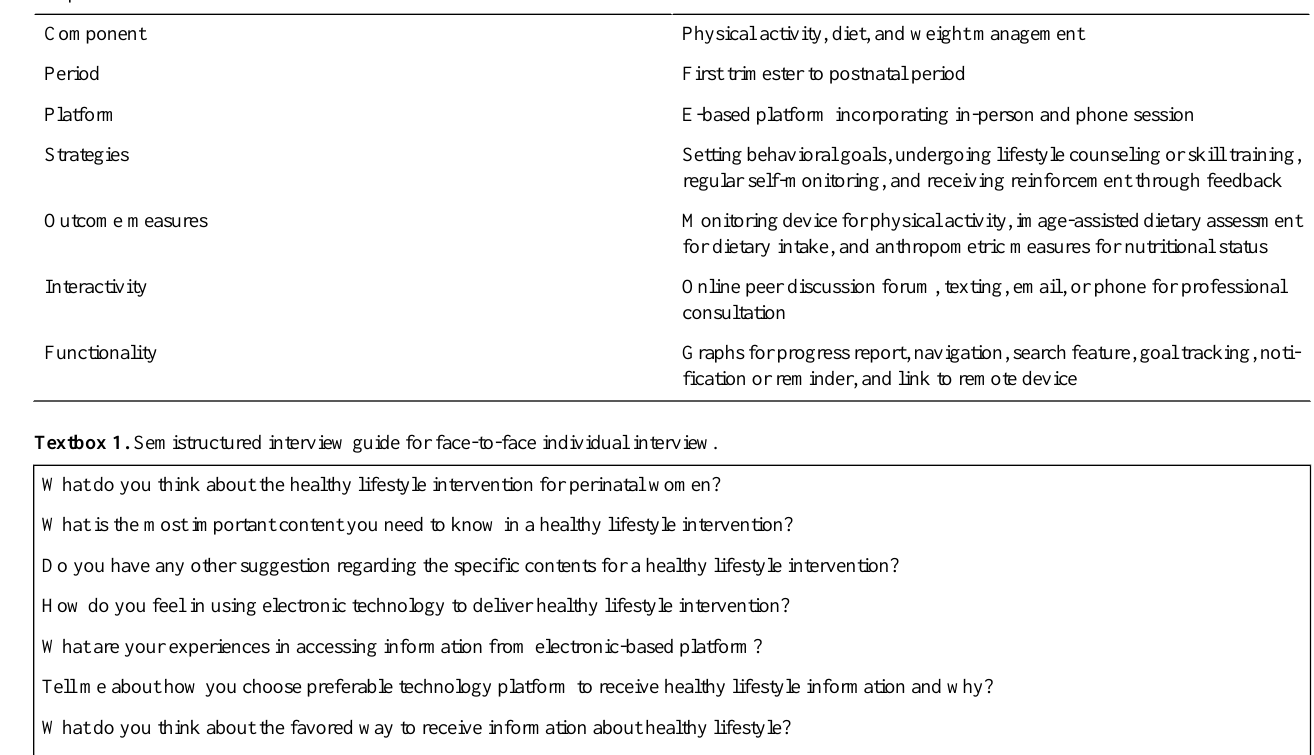
Physical activity, diet, and weight managementComponent First trimester to postnatal